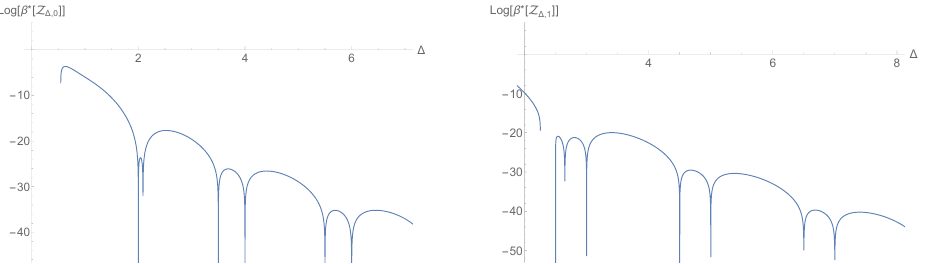
Figure 9. The extremal functional (cid:12) (cid:3) acting on spin-0 (left) and spin-1 (right) primaries at c = 7 and (cid:1) t = 3 2